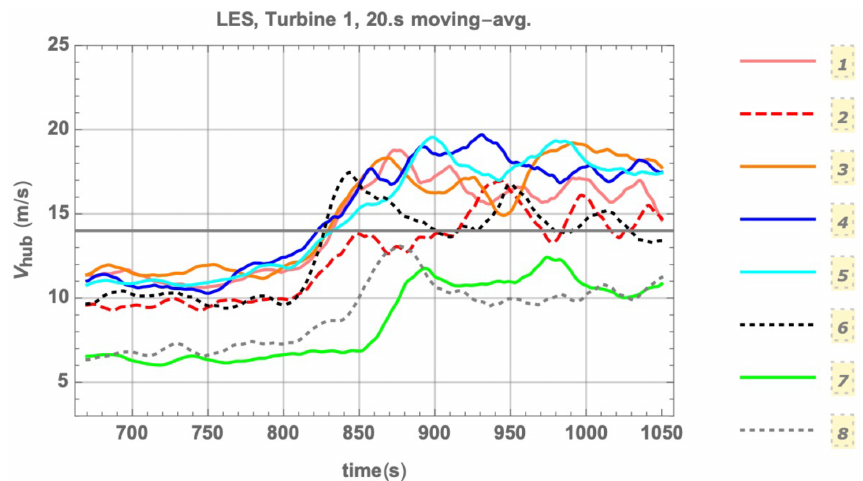
Figure 11. Wind-speed ramps from LES driven by Mann-model simulation, for upwind/first turbine. (Compare to stand-alone Flex5 simu- lations driven by the Mann model, shown in Fig. 9.)